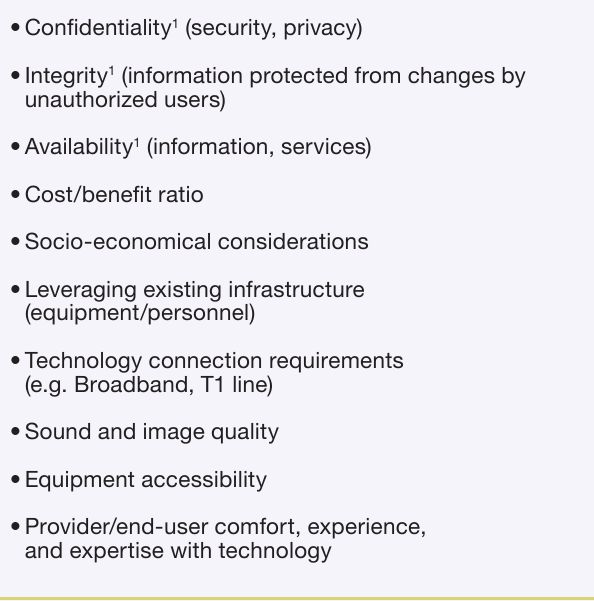
within EI Services Technology Voice Over Internet Protocol (VoIP Technologies) Example Skype, Oovoo, iChat Google Voice and Video Chat,